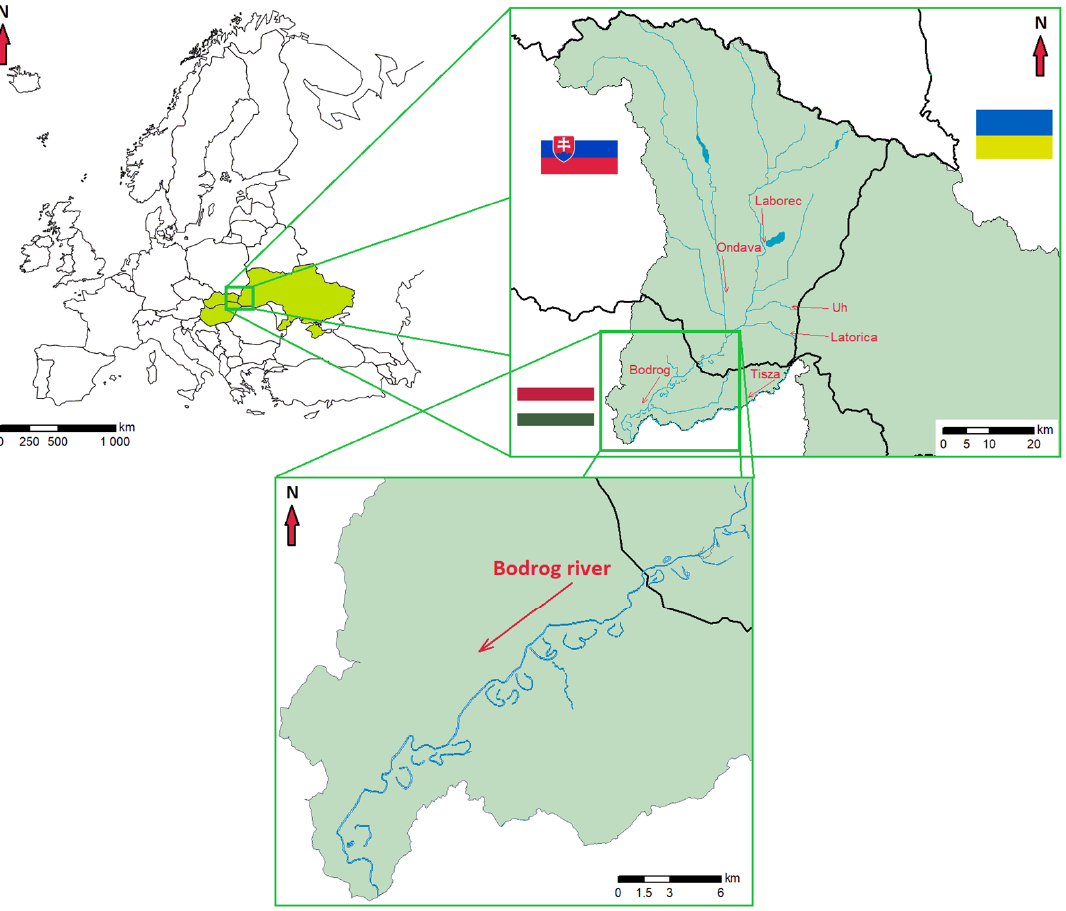
Figure 1. Graphic visualisation of the geographical location of Bodrog basin, with the imaged detail of Bodrog river channel.